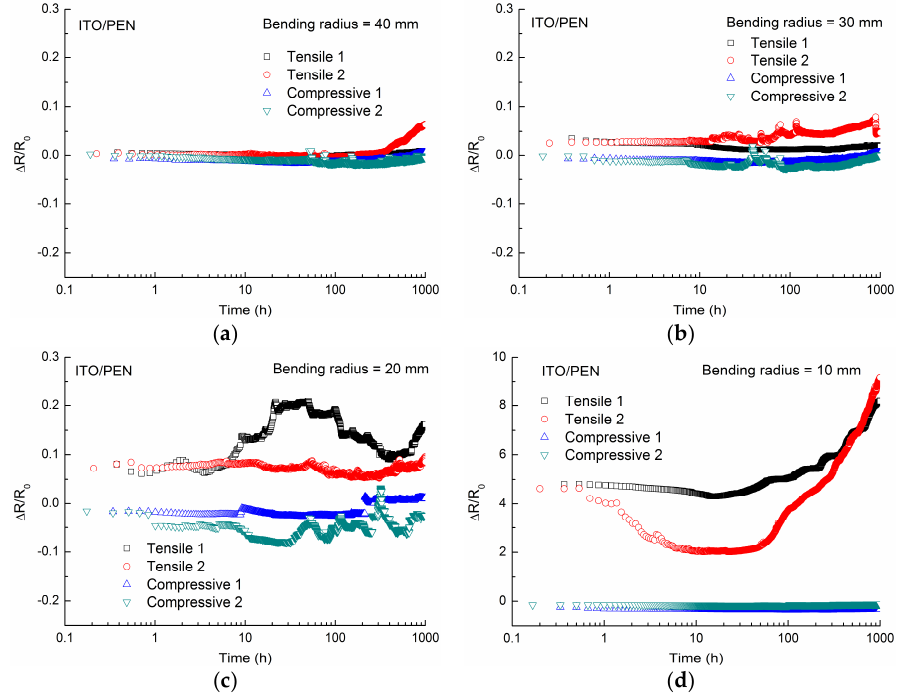
Figure 3. Electrical resistance change of ITO/PEN (polyethylene naphthalate) sheet under static bending of various radii: ( a ) 40 mm; ( b ) 30 mm; ( c ) 20 mm; and ( d ) 10 mm.